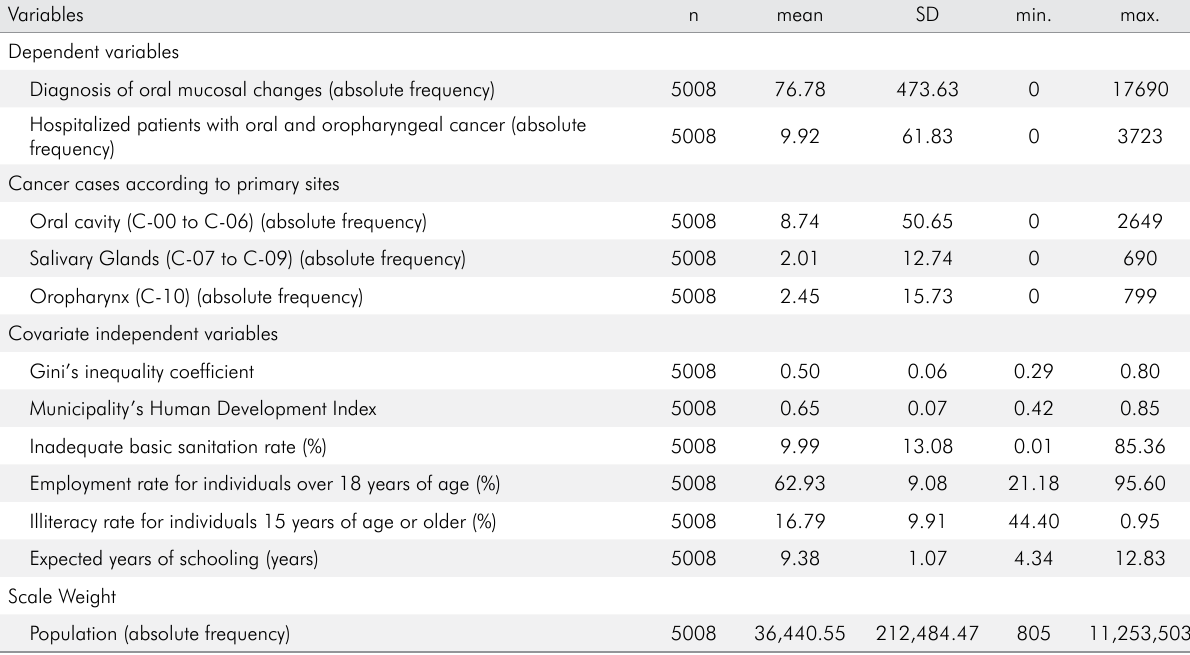
Table 1. Descriptive data of dependent, independent and weight variables considered for analysis. Variables